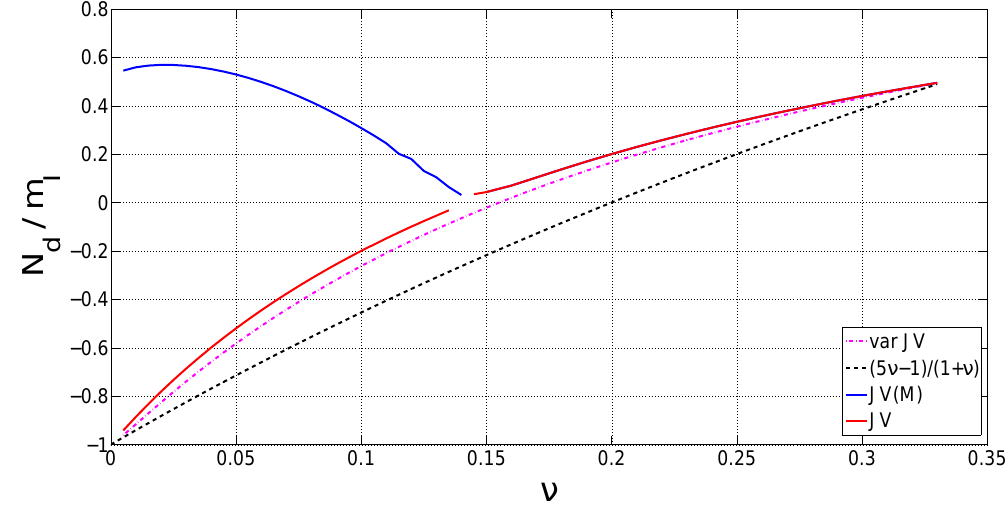
Figure 14: Missing particle number over inertial mass for Josephson vortices (red lower solid line, labeled ‘JV’) and Josephson vortex maxima (blue upper solid line, labeled ‘JV(M)’) as a function of tunneling strength with γ = 1, evaluated at the extrema of the dispersion = 0). The magenta dash-dotted line is an approximate result obtained from a relation ( i.e. v s variational calculation for Josephson vortices (labeled ‘var JV’), and the black dashed line is a prediction from Ref. [ 44 ]